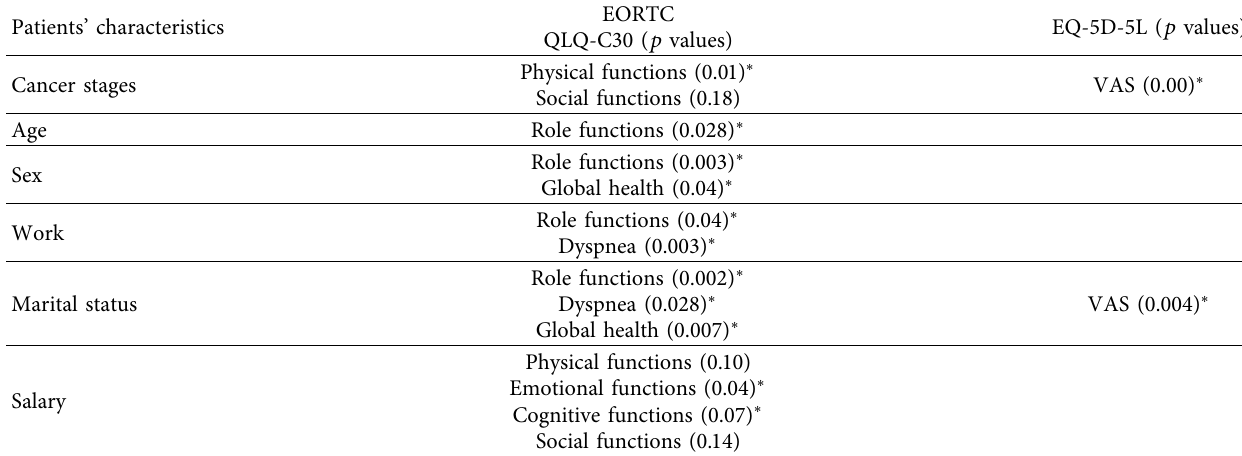
Table 6: Te patients’ characteristics related to the EORTC QLQ-C30 and EQ-5D-5L domains. Patients’ characteristics